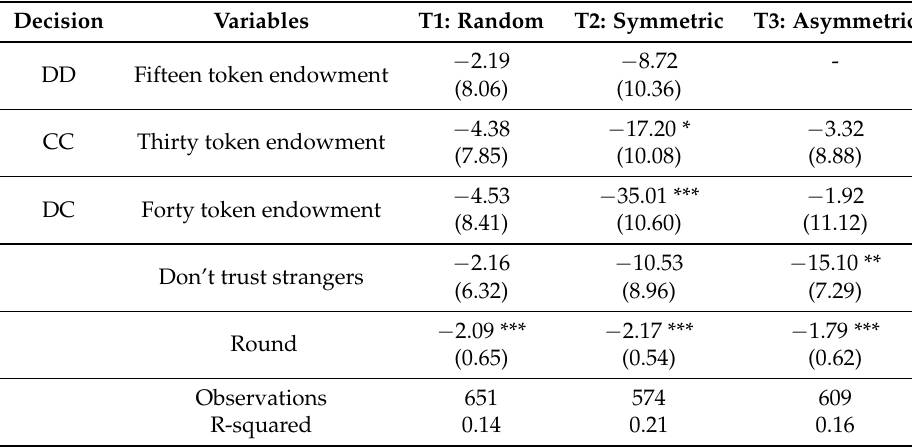
Table 7. Effects of the Origins of Wealth